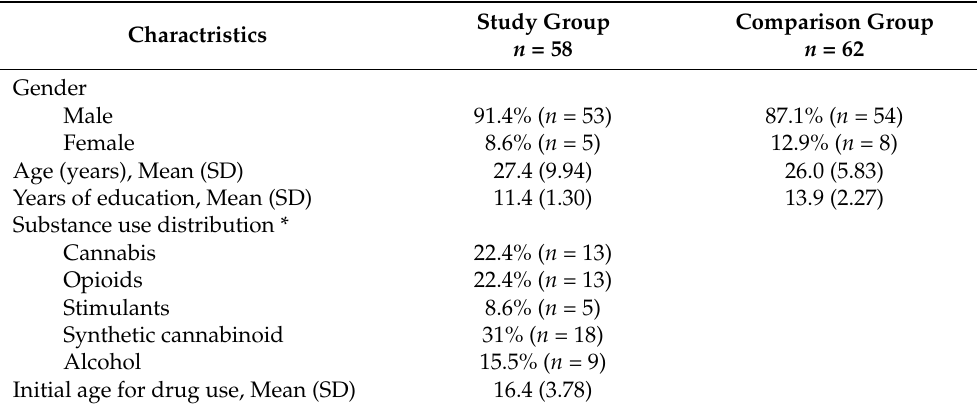
Table 1. Gender, age, and years of education distribution in the two groups, and substance use divided into categories in the study group.